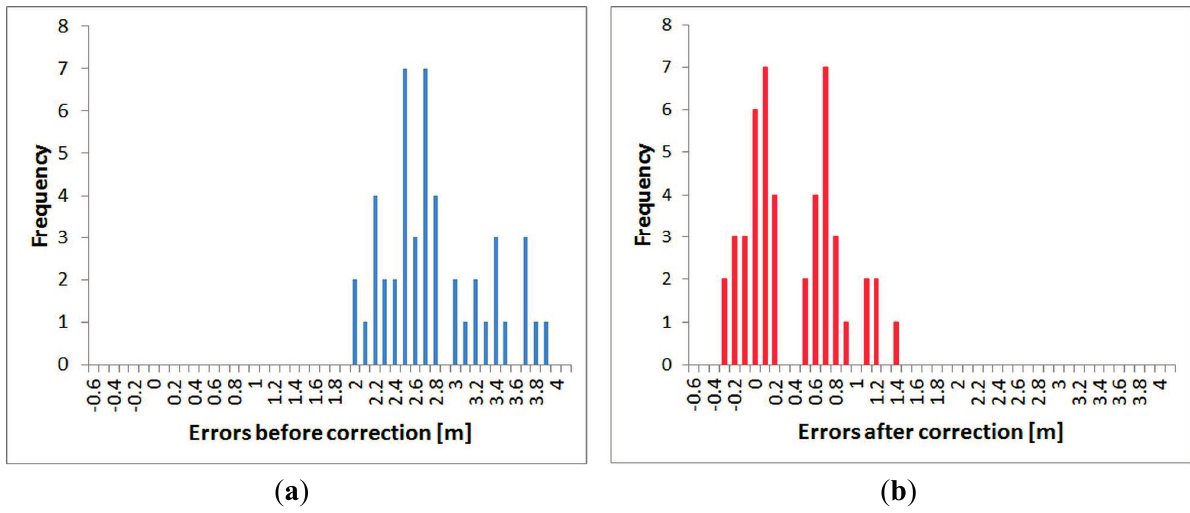
Figure 40. Distribution of the errors–Topcon GPT-7501: ( a ) before the correction; ( b ) after the